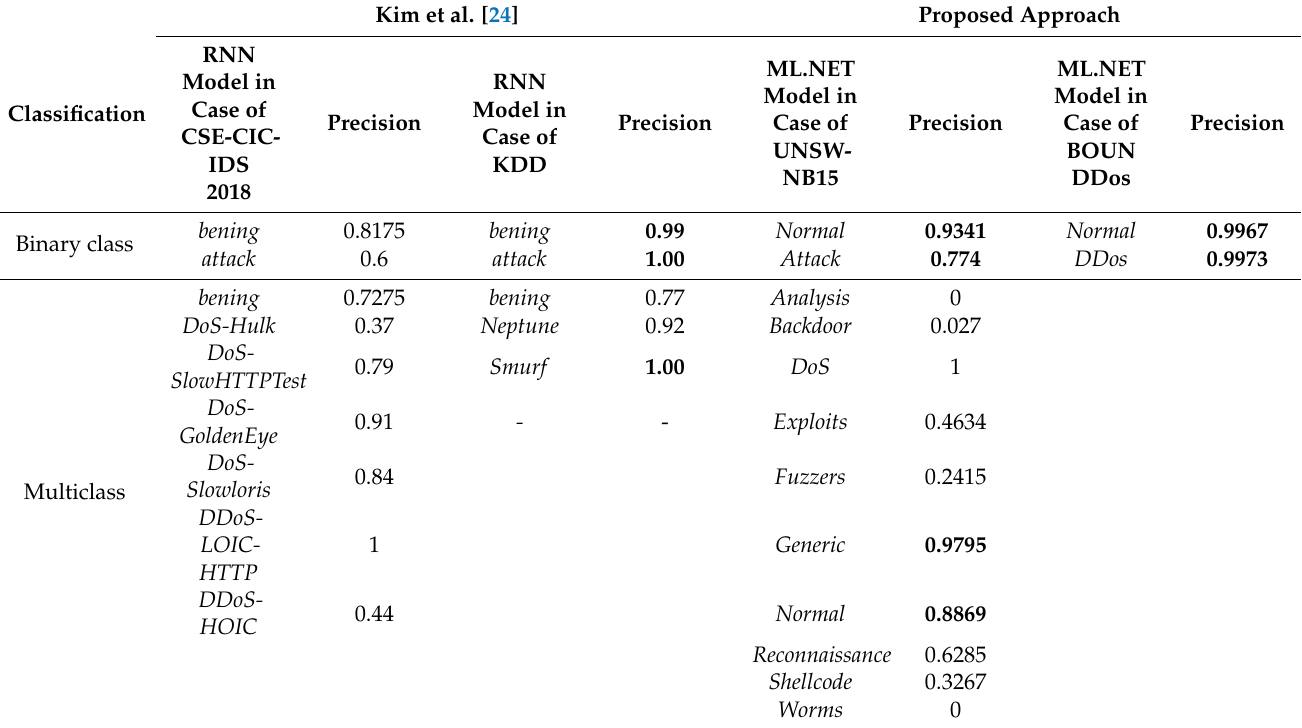
Table 9. Comparison of intrusion detection precision of recognized images using ML.NET created model on UNSW-NB15 training dataset employing oversampling